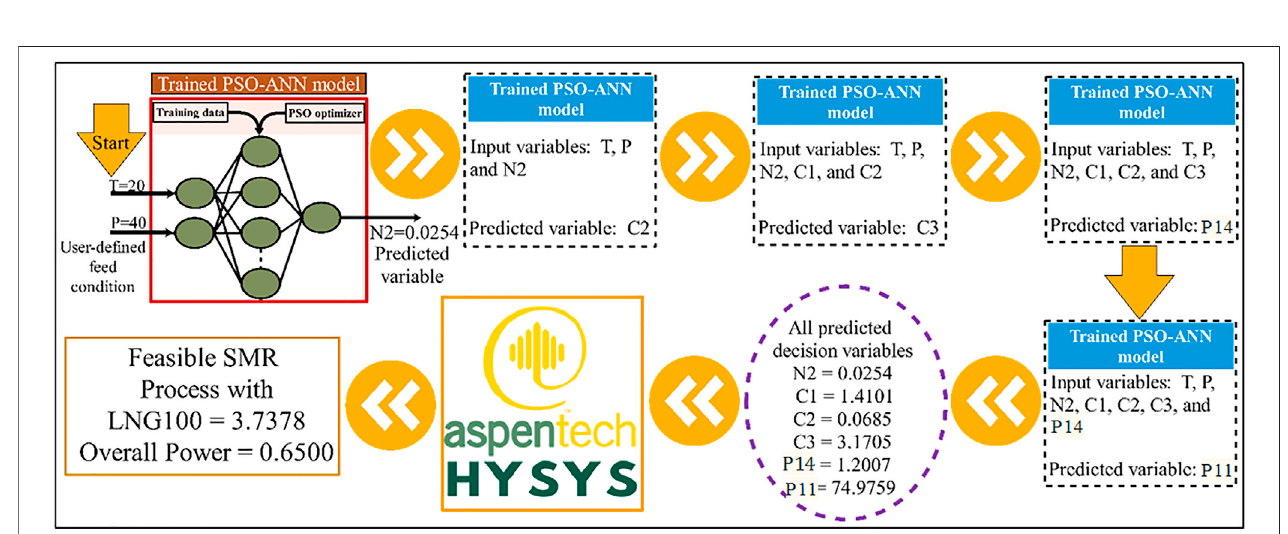
FIGURE 9 | Demonstrative example of cascaded training and the prediction procedure of the PSO-ANN model.